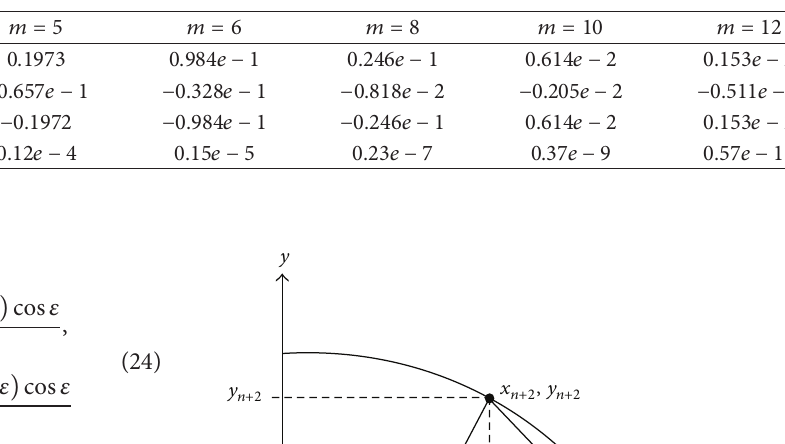
Table 2: Maximum values of the absolute radial error ( 𝑅 = 2 2𝑚+3 ).